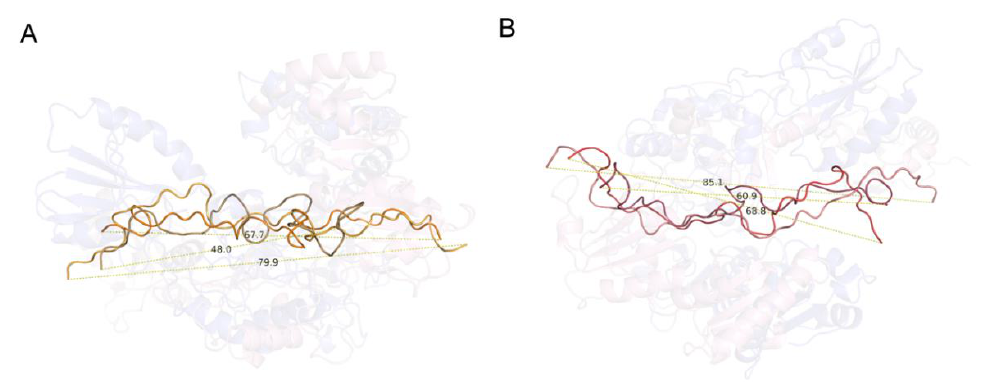
Figure 7. Compression of the repetitive sequence by wPDI. ( A ) cartoon representation of WRS free in solution (bright orange), bound with wPDI O (orange) and wPDI R (sand). ( B ) cartoon representation of DRS free in solution (salmon), bound with wPDI O (tv_red) and wPDI R (raspberry). The repetitive sequences are aligned and corresponding wPDI are transparent in the background. The distance between the C α at the N- and C-terminals of the repetitive sequences were measured.